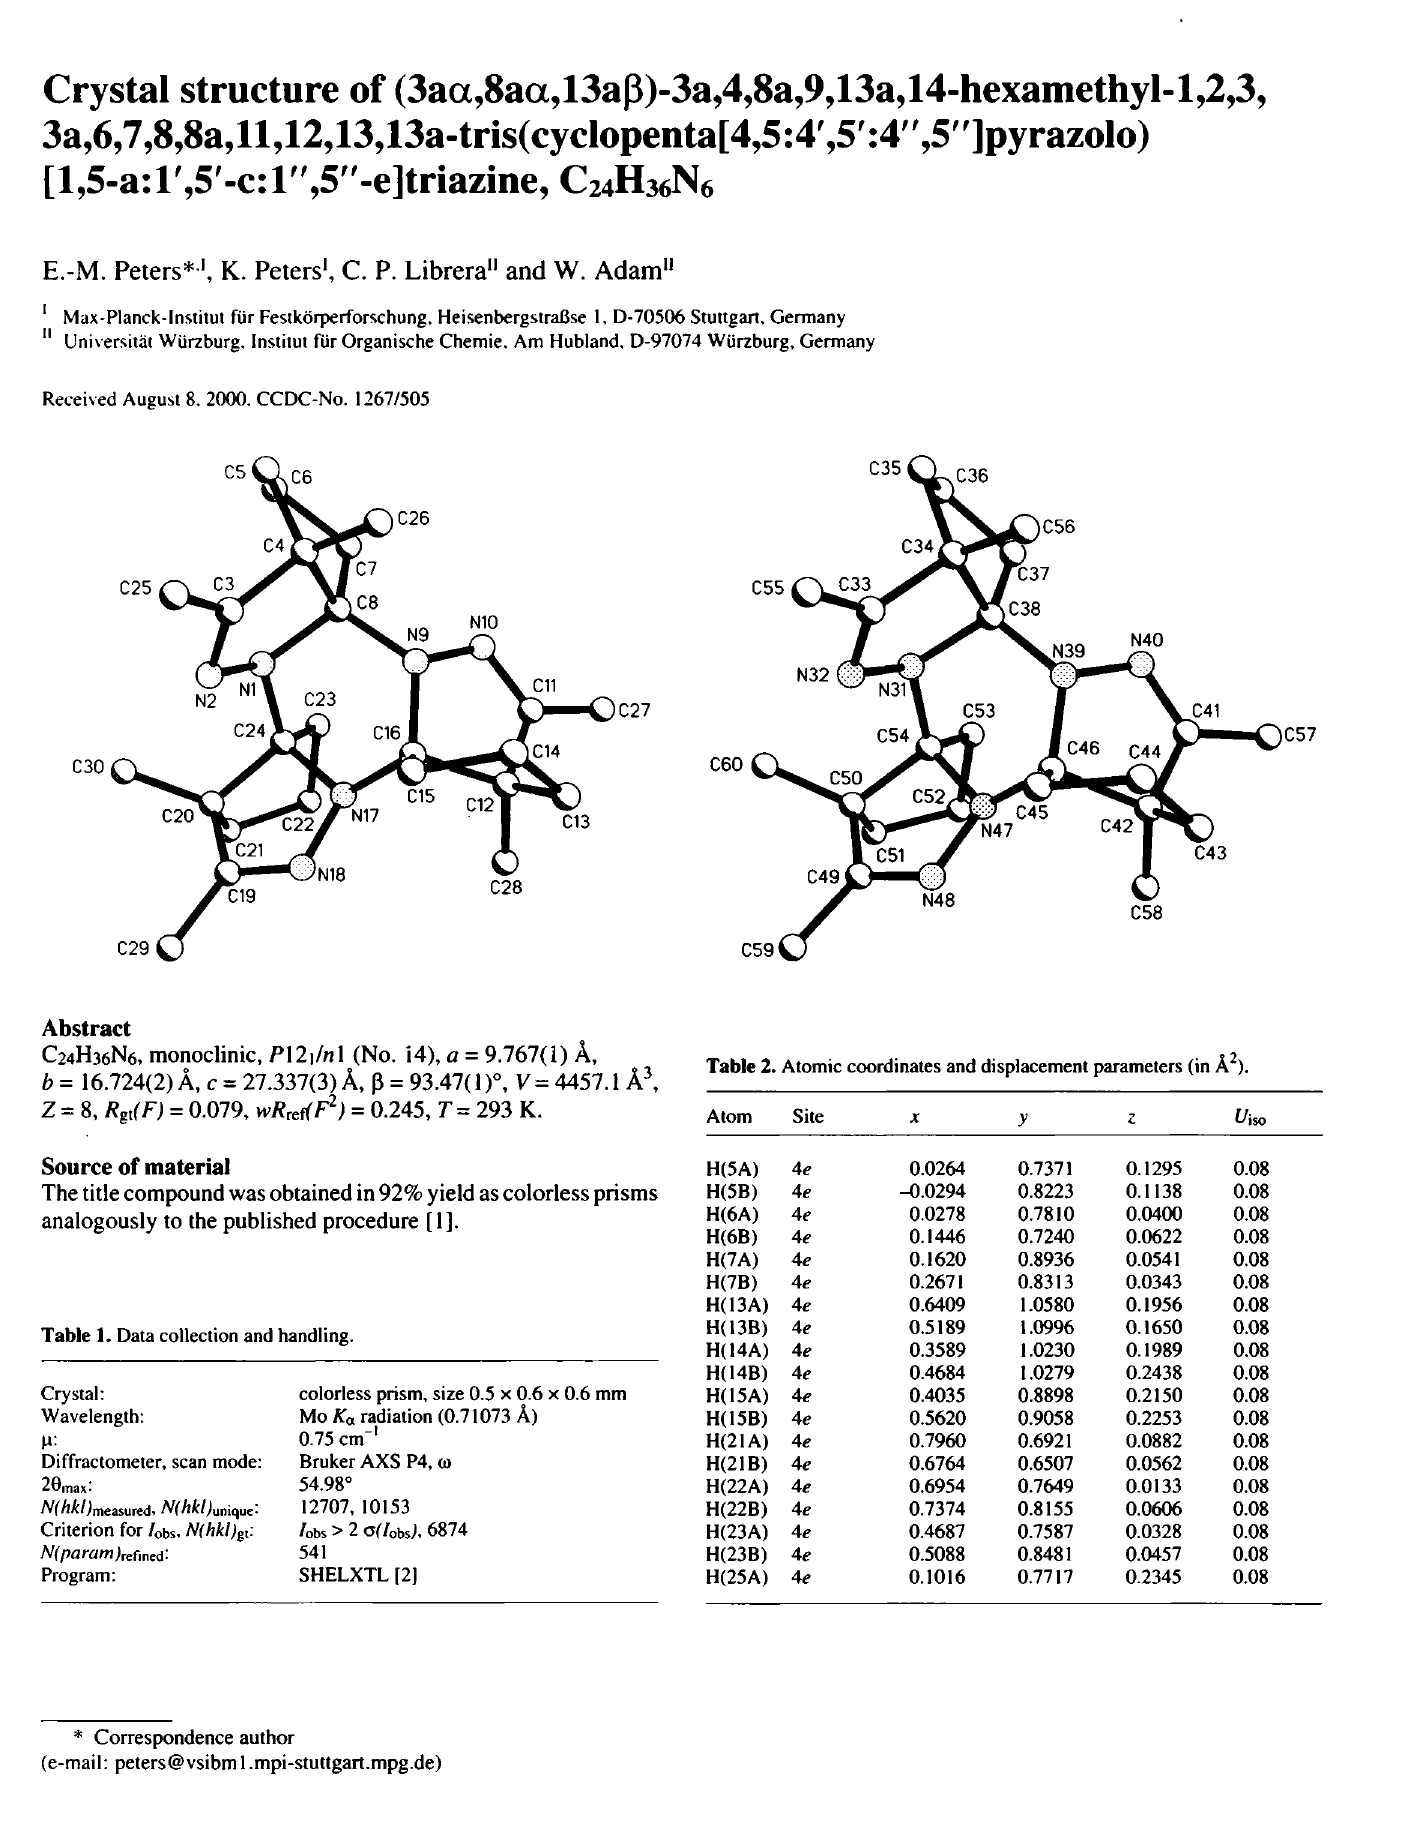
Table 1. Data collection and